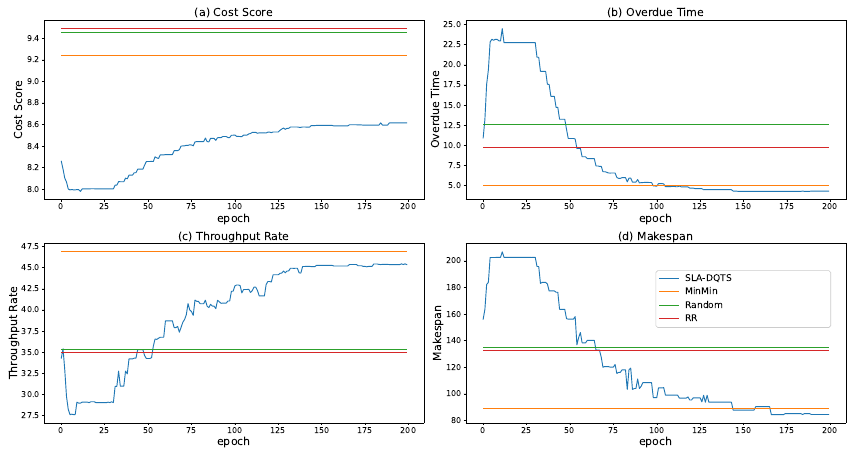
Figure 4. Performance of SAL-DQTS algorithm and comparison algorithms under high-load environment.